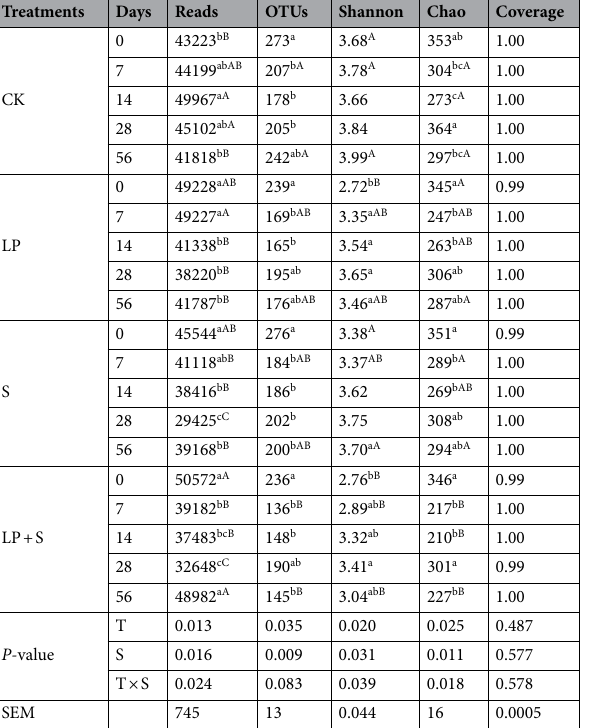
Table 4. Alpha diversity of bacterial community in alfalfa silage during ensiling. a–d Means within a column with different superscripts differ ( P < 0.05); A–E Means within a raw with different superscripts differ ( P < 0.05). CK, control; LP, Lactobacillus plantarum ; S, sucrose; LP + S, the addition of both sucrose and Lactobacillus plantarum ; T: effect of treatment; S: effect of storage period; T × S: interaction between treatment and storage period; SEM, standard error of means.